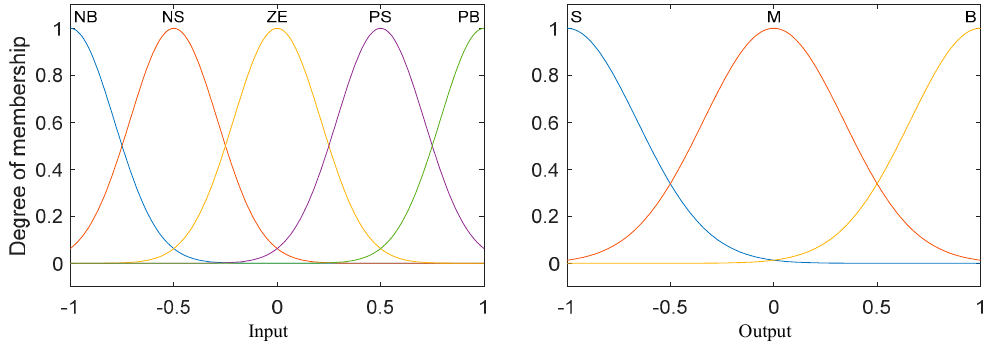
Figure 5. Membership functions of the input and output variables.